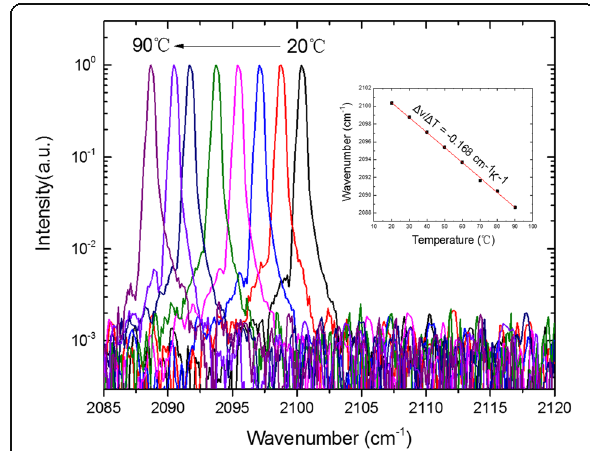
Fig. 5 Single-mode emission spectra of the DFB laser at a driving 1.1